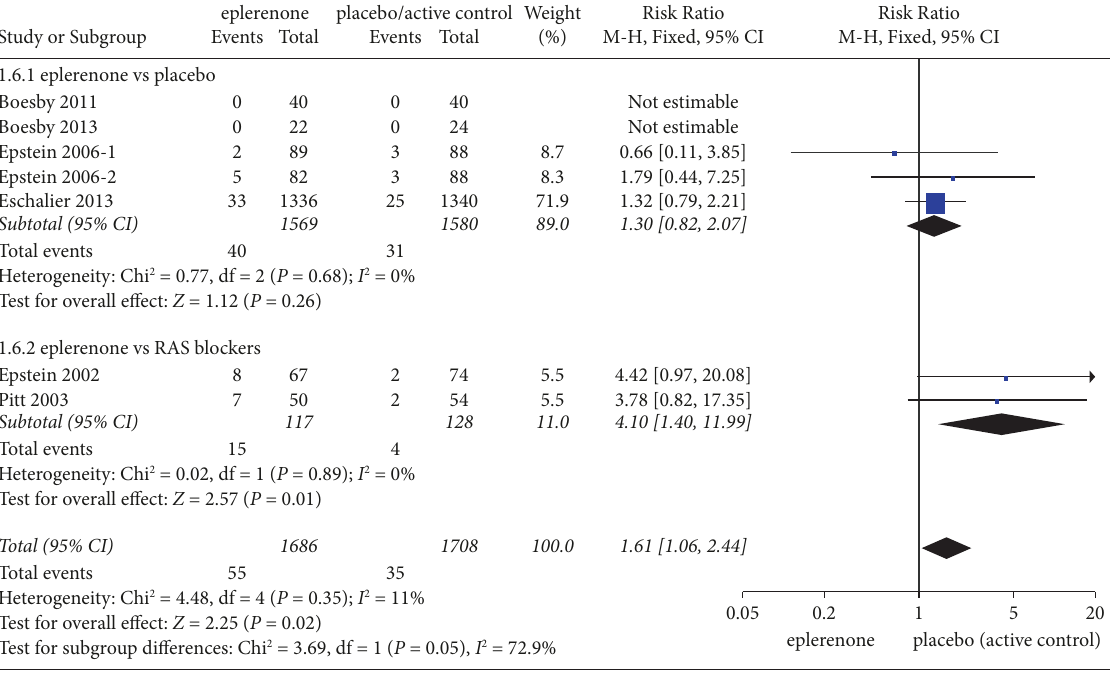
Figure 7: (a) Incidence of hyperkalemia ( ≥ 5.5 mmol/l) in articles comparing eplerenone to placebo/active control. (b) Incidence of hyperkalemia ( ≥ 6.0 mmol/l) in articles comparing eplerenone to placebo/active control. Te black diamond represents summary data with the center of the estimate pooled with the risk ratio, and the width covers the corresponding 95%